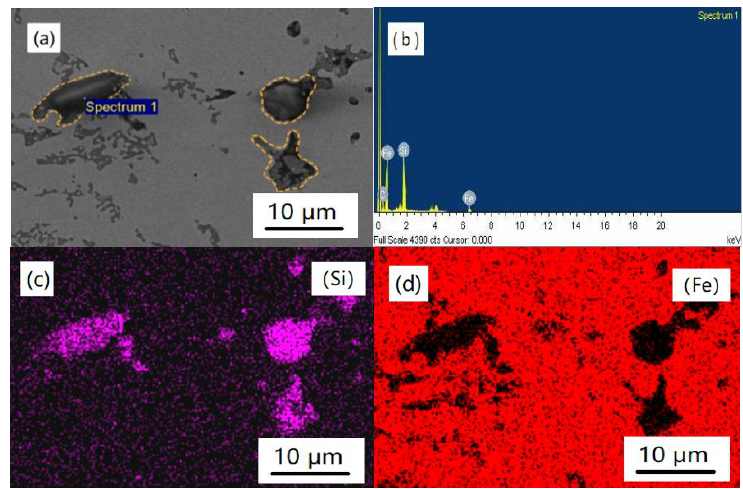
Figure 4. Morphology and EDS analysis results of TiC x in the (Ti 3 AlC 2 + SiC)/Fe composites: ( a ) micrograph, ( b ) EDS results of spectrum 1, ( c ) Fe, ( d ) Ti, and ( e ) Al.